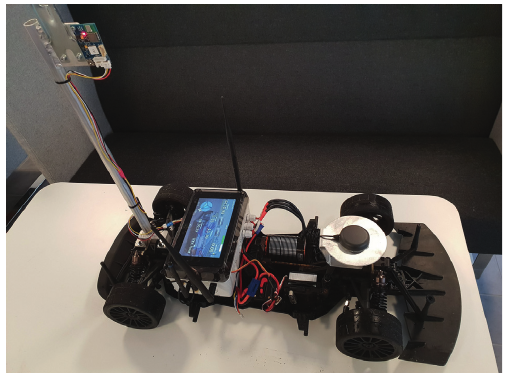
Figure 1: Photo of our self-driving model car with our UWB module attached to the back on a stick.